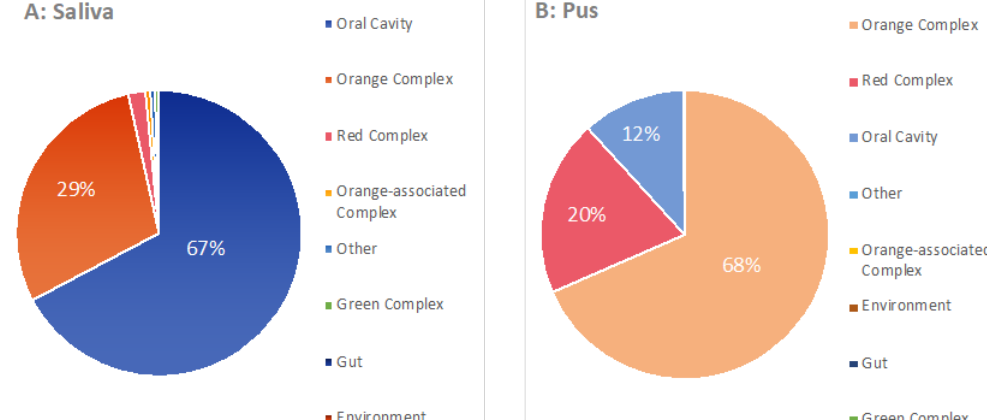
Figure 11. Classification of the median microbiomes (( A ) saliva ( B ) pus) according to the complexes described by Socran- Scheme 50. [21]. Bacteria of the red and orange complex are associated with strong pathogenicity in periodontal disease. The genus Streptococcus (otherwise yellow complex) was assigned to the “oral cavity” group in this representation.